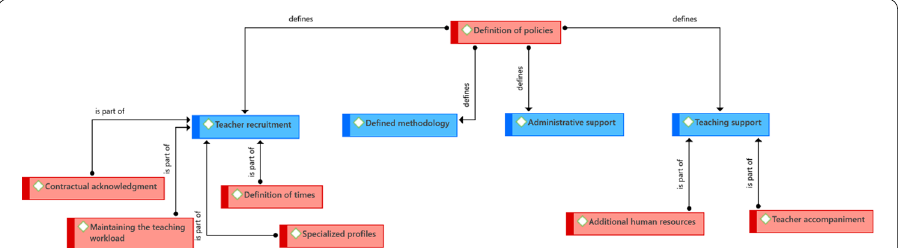
Fig. 9 Structure of driving ideas associated with how the organizational aspect is done. Source: Diógenes